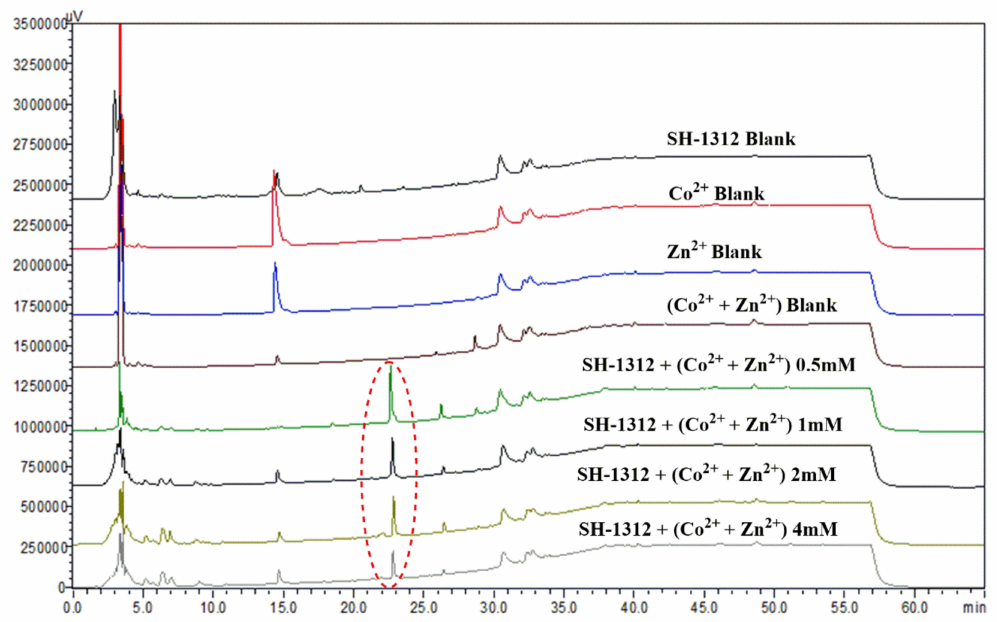
Figure 1. HPLC profile of metal treated and untreated SH-1312 strain with several mixed metals (Co 2+ + Zn 2+ ) ions. The red circle indicates the new peak in the HPLC chromatogram.